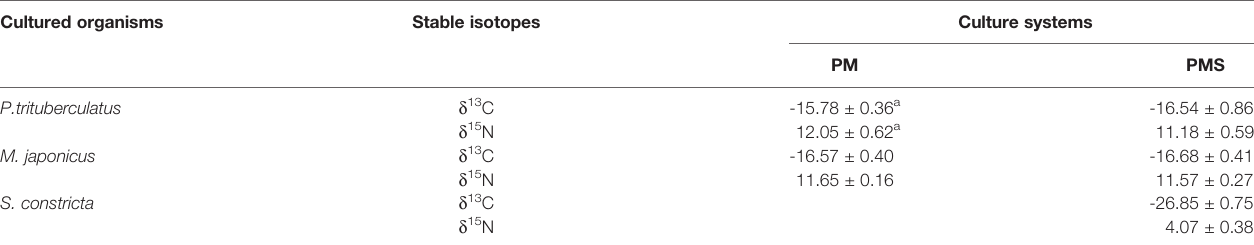
TABLE 1 | d 13 C and d 15 N of cultured organisms ( ‰ ).